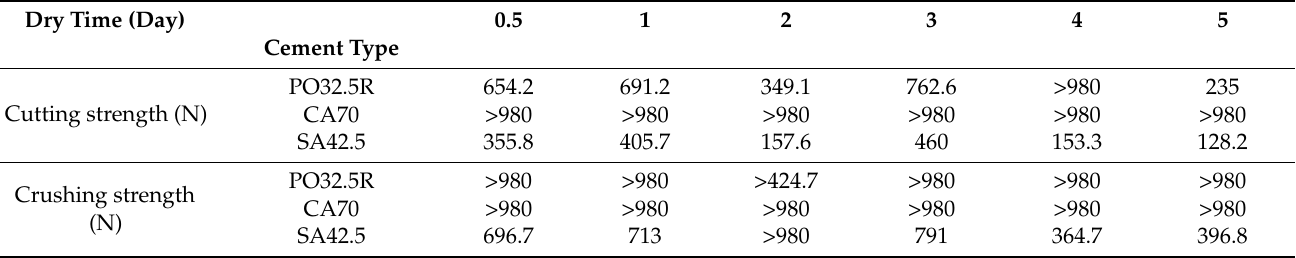
Table 4. Cutting strengths and crushing strengths of the cubic samples using various cements as